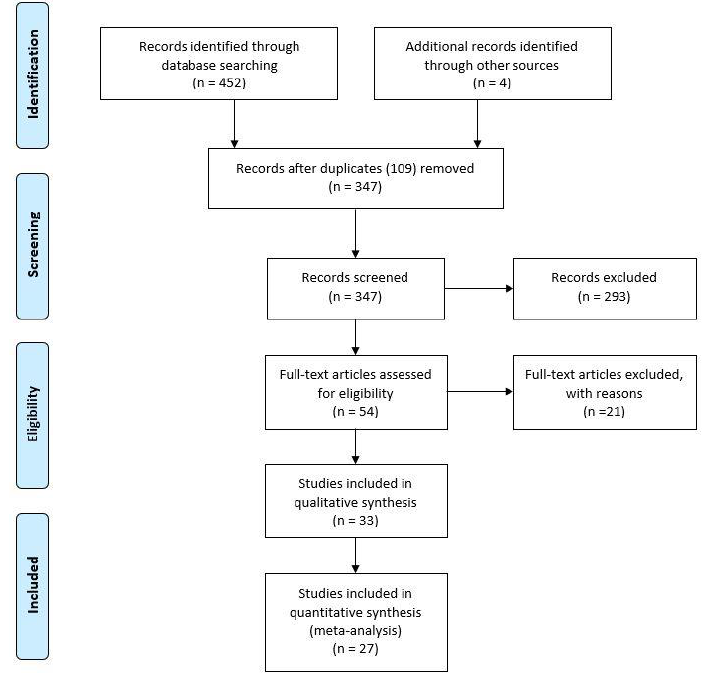
Figure 1. Flow diagram of the study selection process.